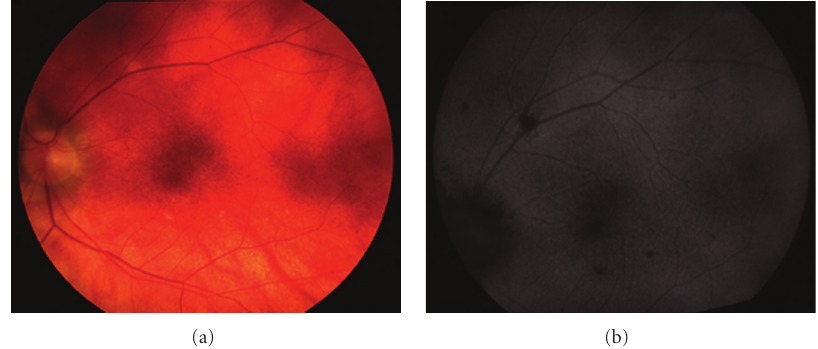
Figure 1: Images from the left eye of a 58-year-old woman with birdshot chorioretinopathy (patient 3). (a) Fundus colour photograph shows poorly pigmented fundus with scatter BSCR around the optic nerve, superior arcade, and inferior to the fovea. (b) Autofluorescence photograph shows scattered areas of RPE atrophy as hypoautofluorescent spots correspondent to the BSCR noted in the colour photograph.